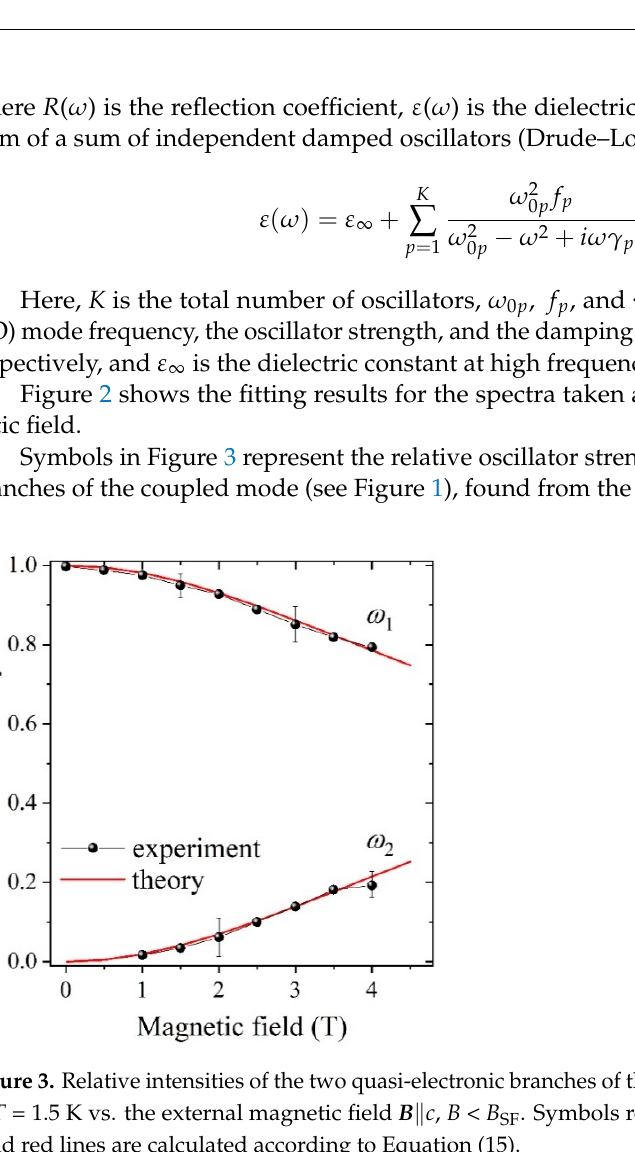
Figure 3. Relative intensities of the two quasi-electronic branches of the coupled mode in PrFe 3 (BO 3 ) 4 at T = 1.5 K vs the external magnetic field B ∥ c , B < B SF . Symbols represent the experimental data; solid red lines are calculated according to Equation (15).